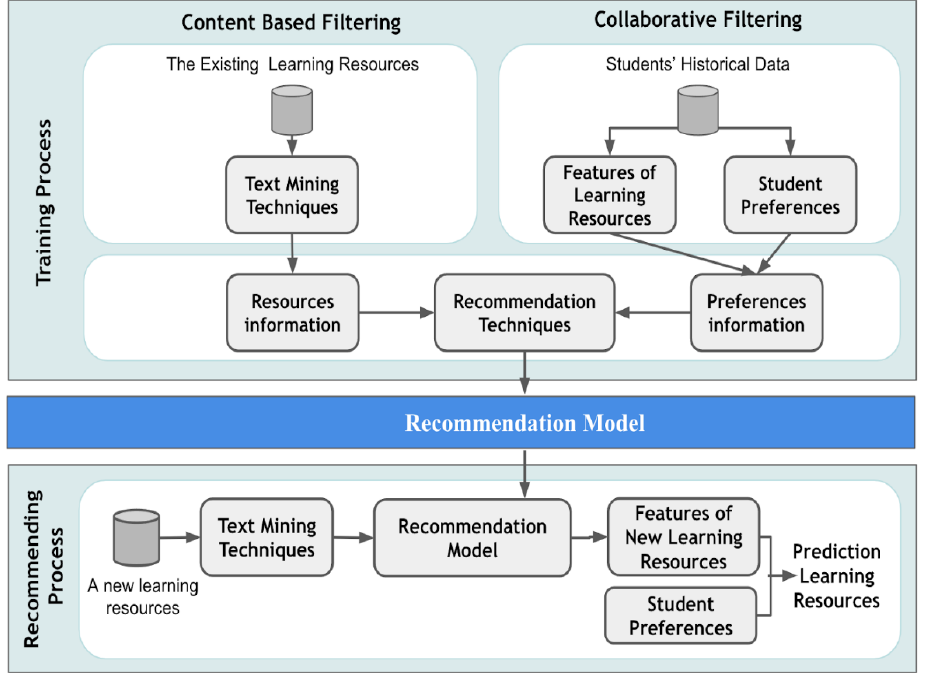
Figure 21. Structure of the educational content recommendation system. Table 10. Study of the education service field recommendation system.